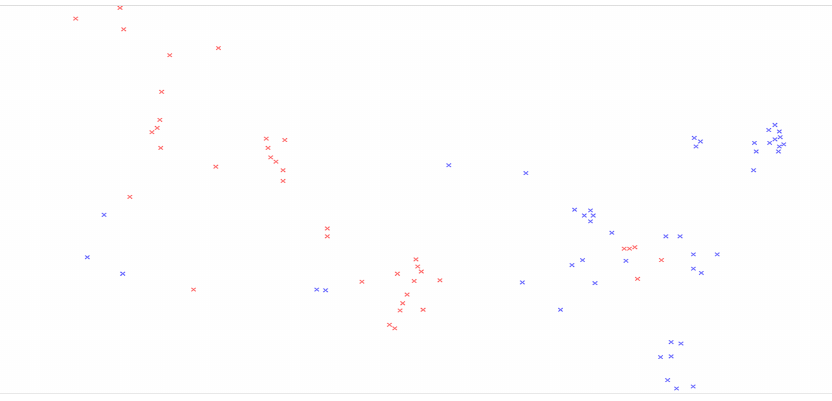
Figure 4: From WEKA: Subset A (cid:21) 377 Counties Performance